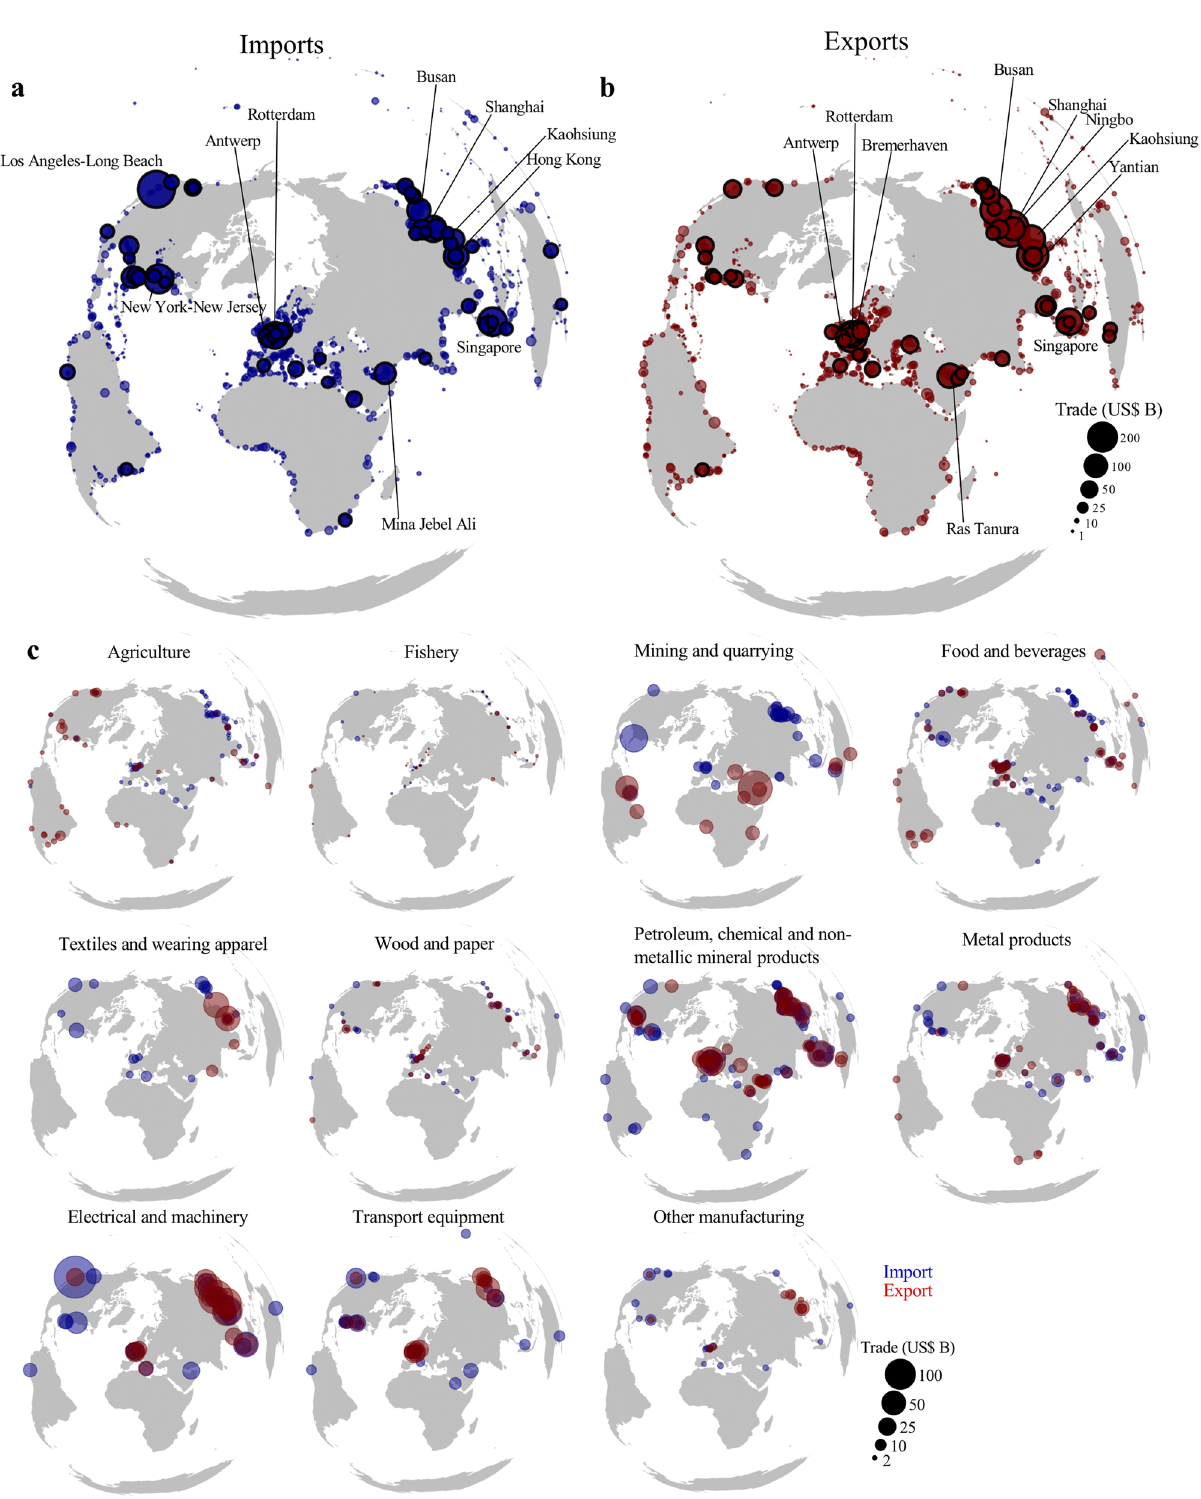
Fig. 2 | Cross-border maritime infrastructure dependencies. a The port-level throughput (import, exports and transhipment) that comes from or goes to ports by passing the Panama canal. b Same as( a ) but for the Suez canal. c The share and